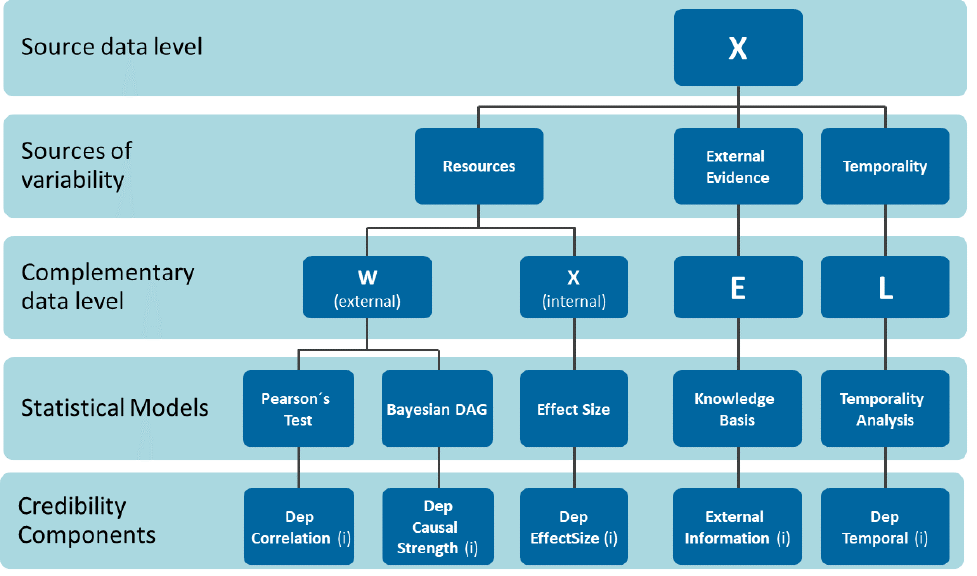
Figure 3. Schema of formation of the Credibility